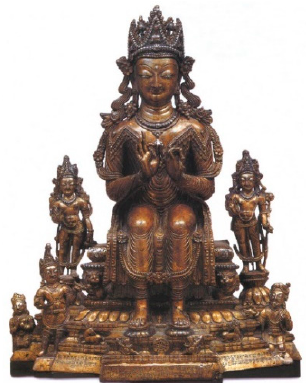
Figure 5. Buddha wearing a crown and cape with crescent moon and sun symbols performing the dharmacakra-pravartana mudr ā . Commissioned by King Nandivikramadityanandi, April or September, 715 C.E. Gilgit. Brass with copper and silver inlay. 36.8 cm H. Pritzker Collection. https://himalayanbuddhistart.files.wordpress.com/2015/08/8th-c-715-gilgit-shakyamuni-brasssil-c-inlay-donorsattendantsdancer-private-col.jpg.